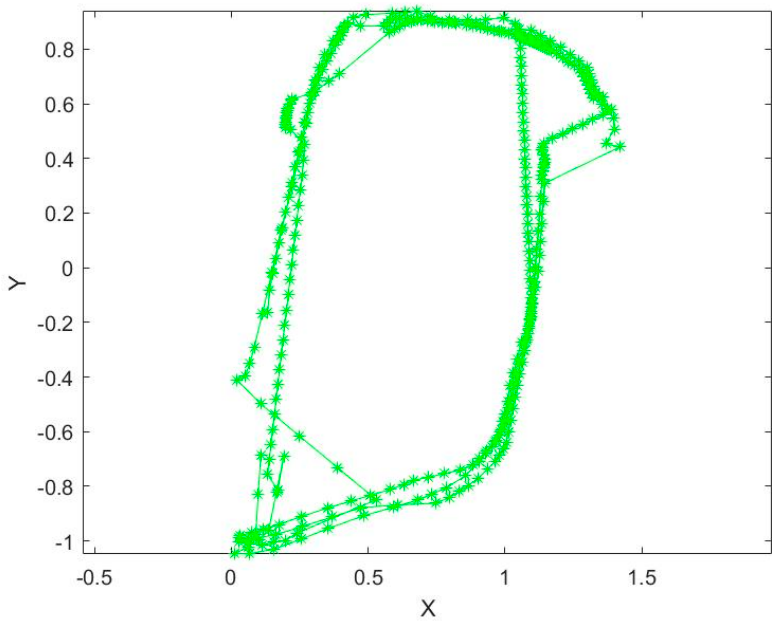
Figure 7. The vision raw positioning results.